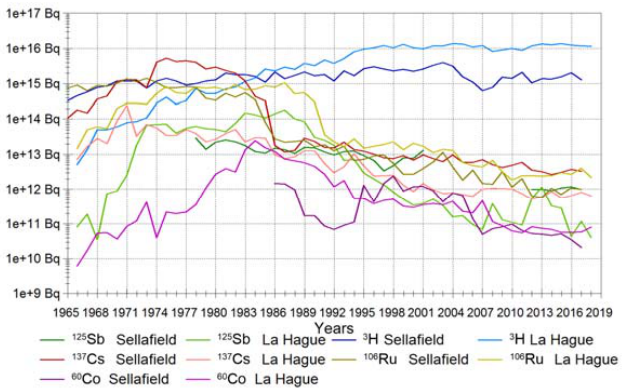
Figure 2. Annual liquid releases from Sellafield and La Hague nuclear reprocessing plants for 125 Sb, 3 H, 137 Cs, 106 Ru and 60 Co. 3 H, 137 Cs, 106 Ru and 60